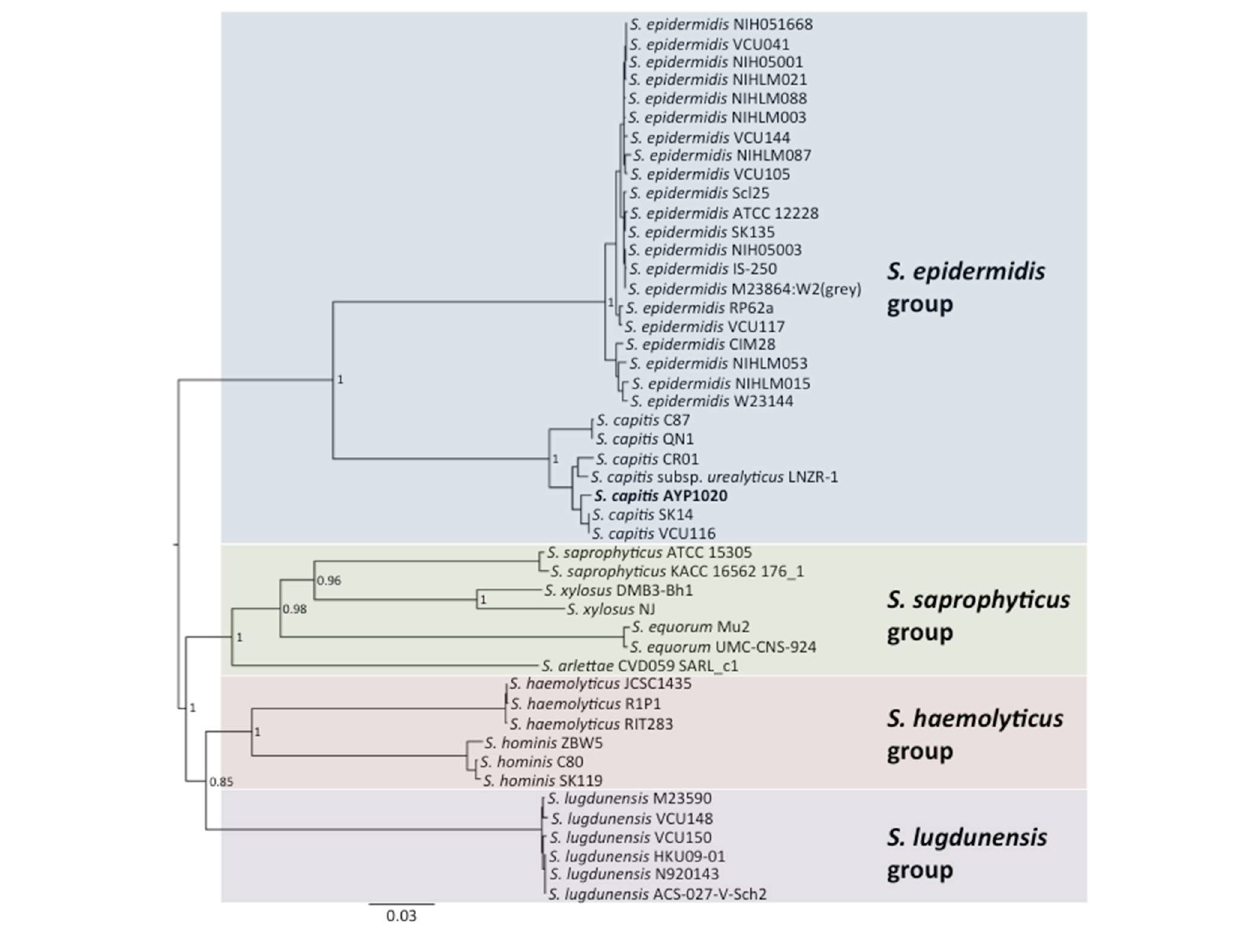
FIGURE 1 | Neighbor-joining tree showing the relationship between S. capitis AYP1020 and other sequenced CoNS strains. Phylogeny was inferred using the MLST scheme developed for S. epidermidis . S. capitis AYP1020 is represented in